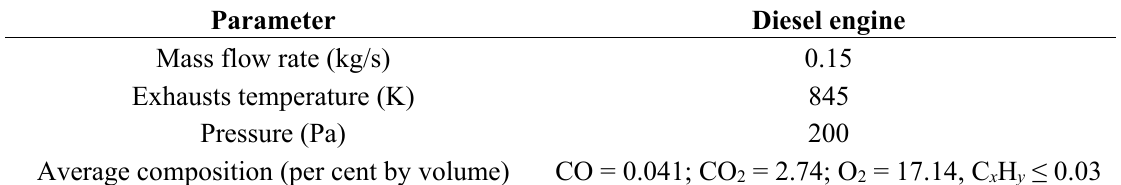
Table 1. Thermal source main data